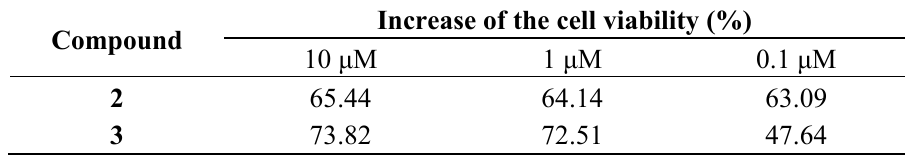
Table 3. Protective effects of 2 and 3 against cardiomyocyte damage induced by pentobarbital sodium.